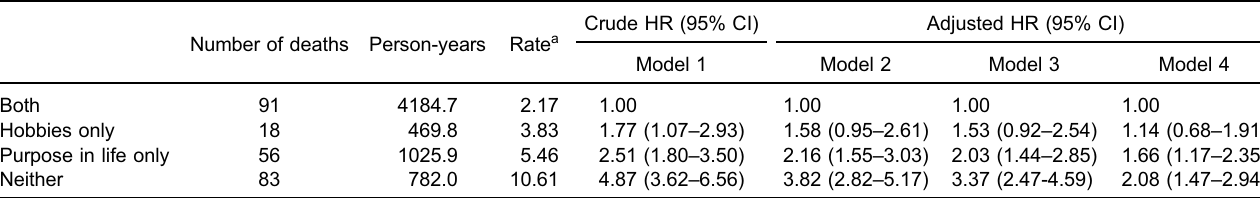
Table 2. Results from cox proportional hazards models of association between hobbies, a purpose in life ( ikigai ), and mortality ( n = 1853) Number of deaths Person-years Rate